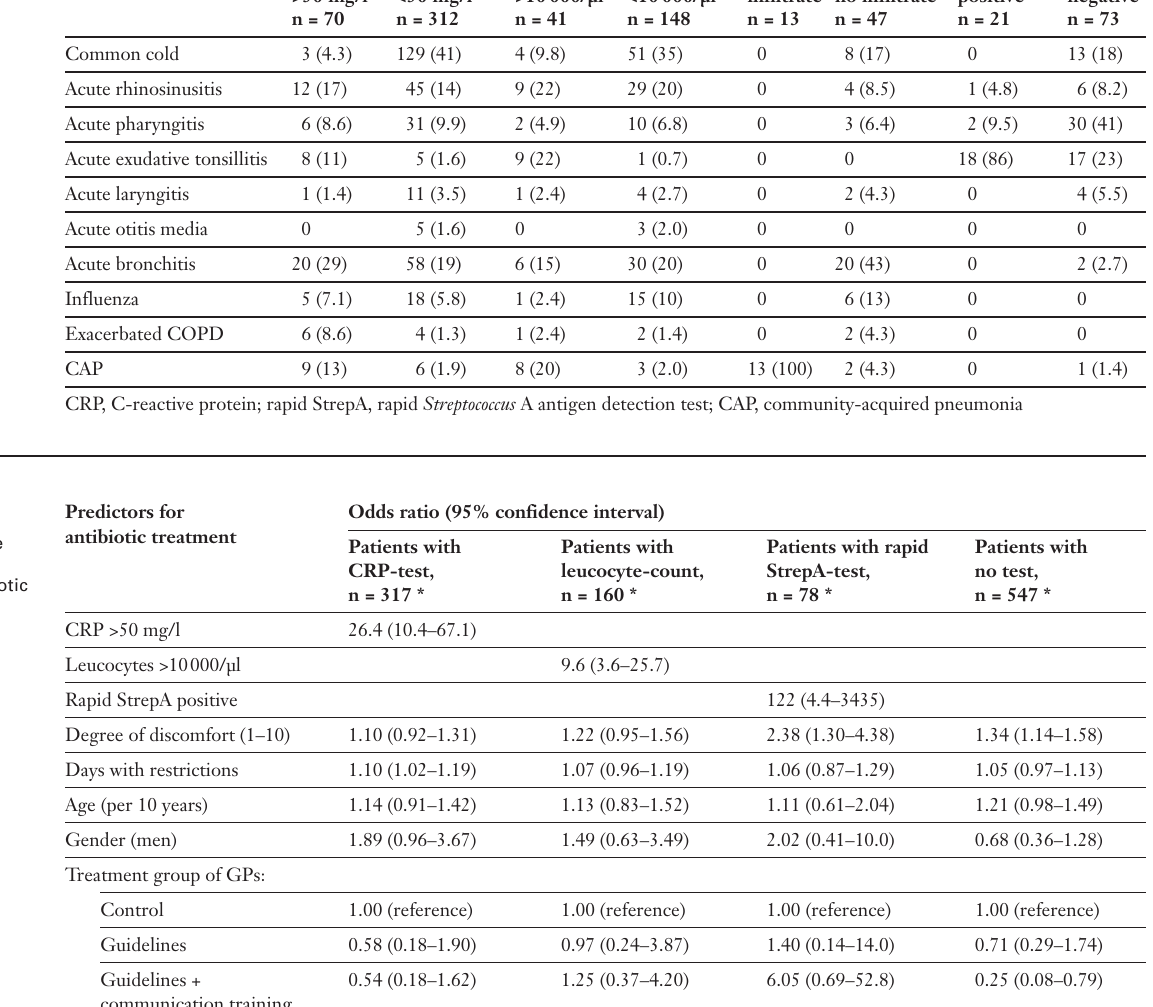
Diagnoses of ARTI by test result.